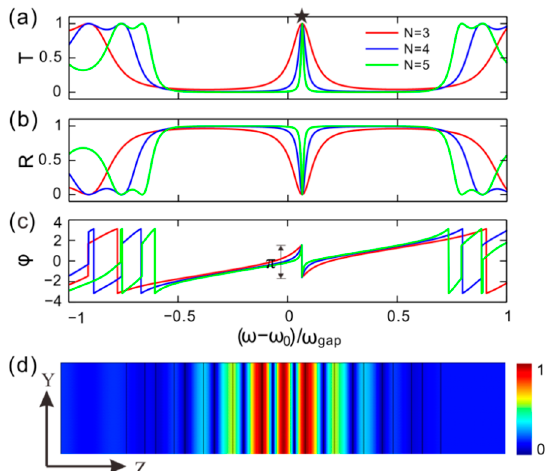
Figure 2. The calculated spectra for the defective photonic crystals (PCs) without graphene. ( a ) The transmission spectrum T . ( b ) The reflection spectrum R . ( c ) The phase of the reflection coefficient. ( d ) Electric field intensity (| E z | 2 ) distribution of the defect mode.